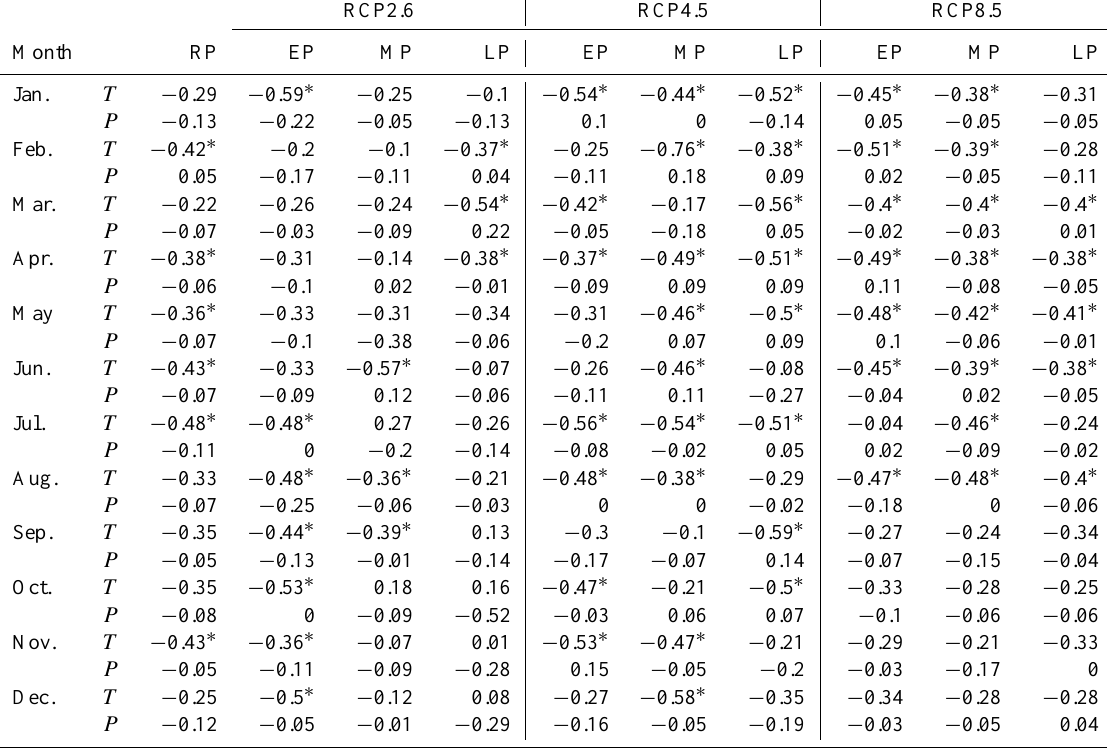
Table 4. Partial correlations between mean annual SWE and both mean temperature ( T ) and precipitation ( P ) over Northern Hemisphere land for three RCPs. RP, EP, MP, and LP represent the periods 1986–2005, 2016–2035, 2046–2065, and 2080–2099, respectively. RCP2.6 RCP4.5